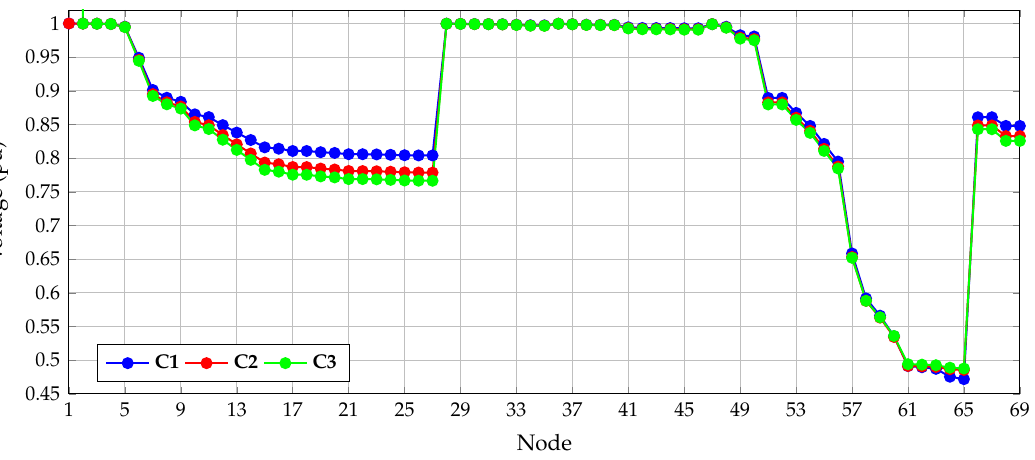
Figure 7. Behavior of the voltage profiles in the benchmark case, i.e., C1, and simulation cases C2 and C3 with three dispersed generators for the IEEE 69-bus